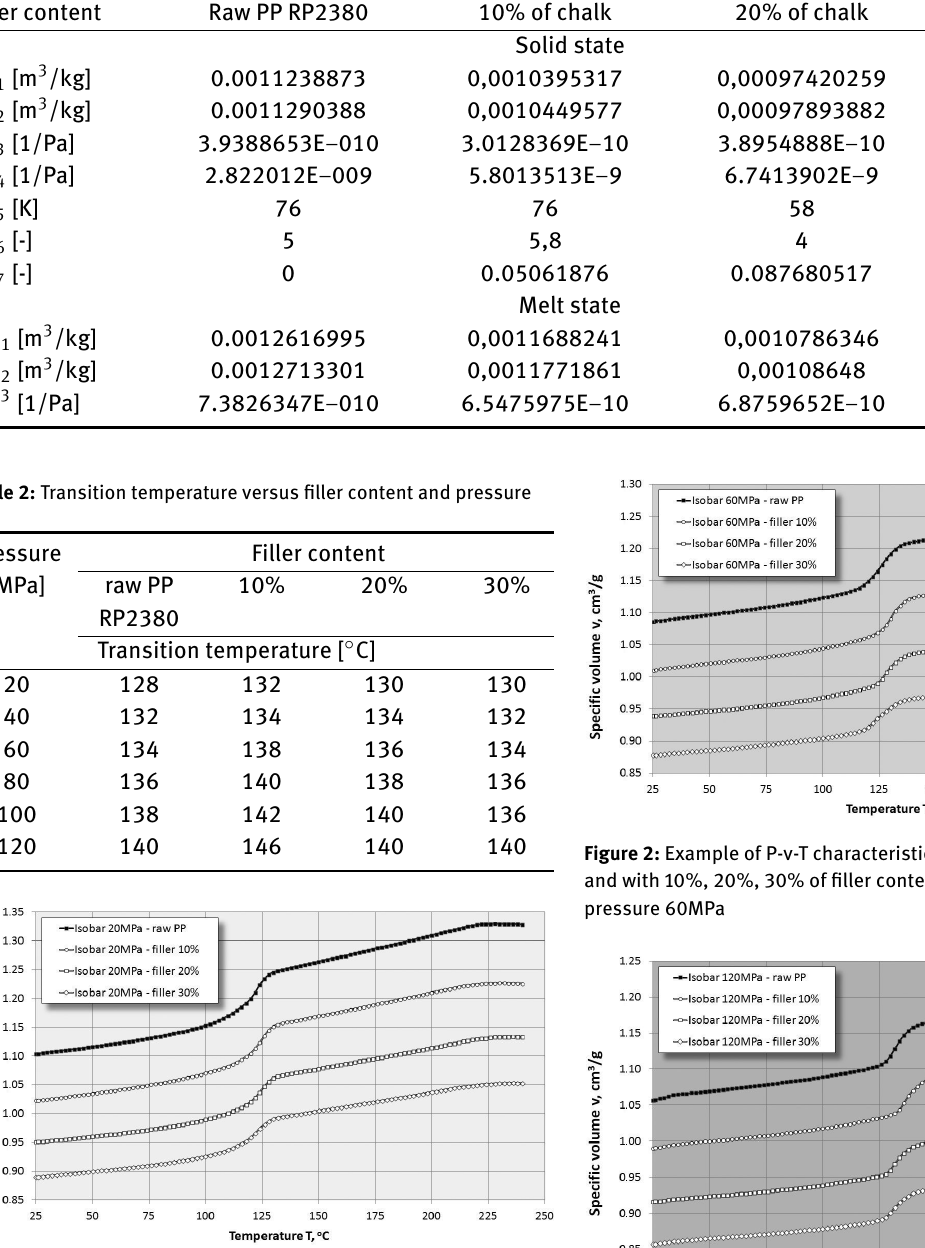
Figure 1: Example of P-v-T characteristic for raw PP Moplen RP2380 and with 10%, 20%, 30% of filler content obtained at a low pressure 20MPa